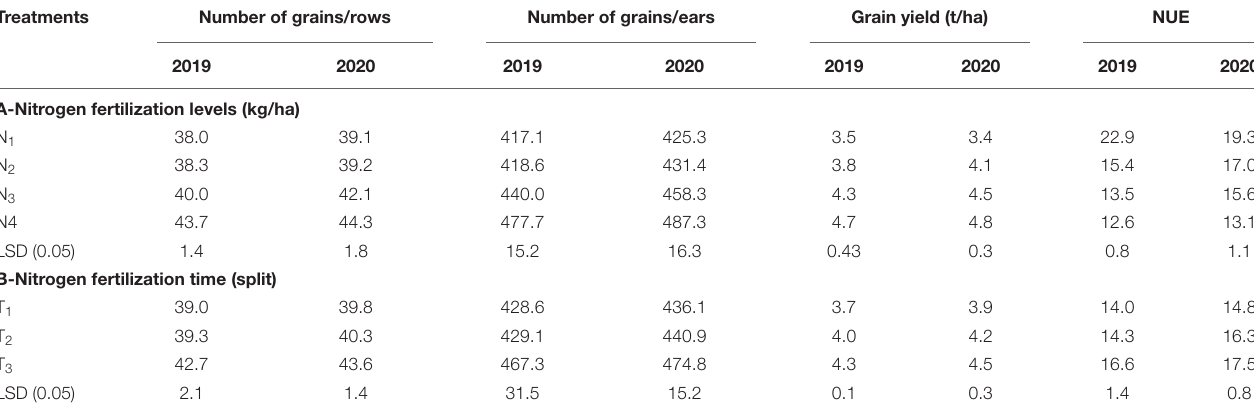
TABLE 6 | Plant attribute of maize ( Zea mays cv. SC. 10) as affected by nitrogen levels and time of application in 2019 and 2020 seasons. Treatments Number of grains/rows Number of grains/ears Grain yield (t/ha) NUE